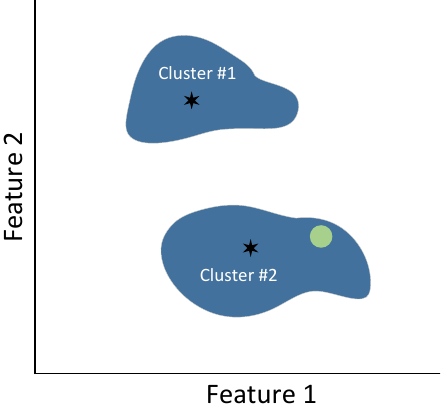
Figure 6. Graphical representation of a sample labelling using